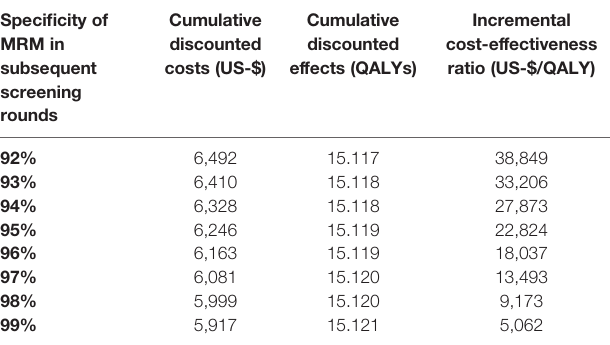
TABLE 3 | Cost-effectiveness of MR-mammography (MRM) for varying speci fi cities of MRM in the second and the following screening rounds, with cumulative costs and effects and the incremental cost-effectiveness ratio compared to x-ray mammography. Speci fi city of MRM